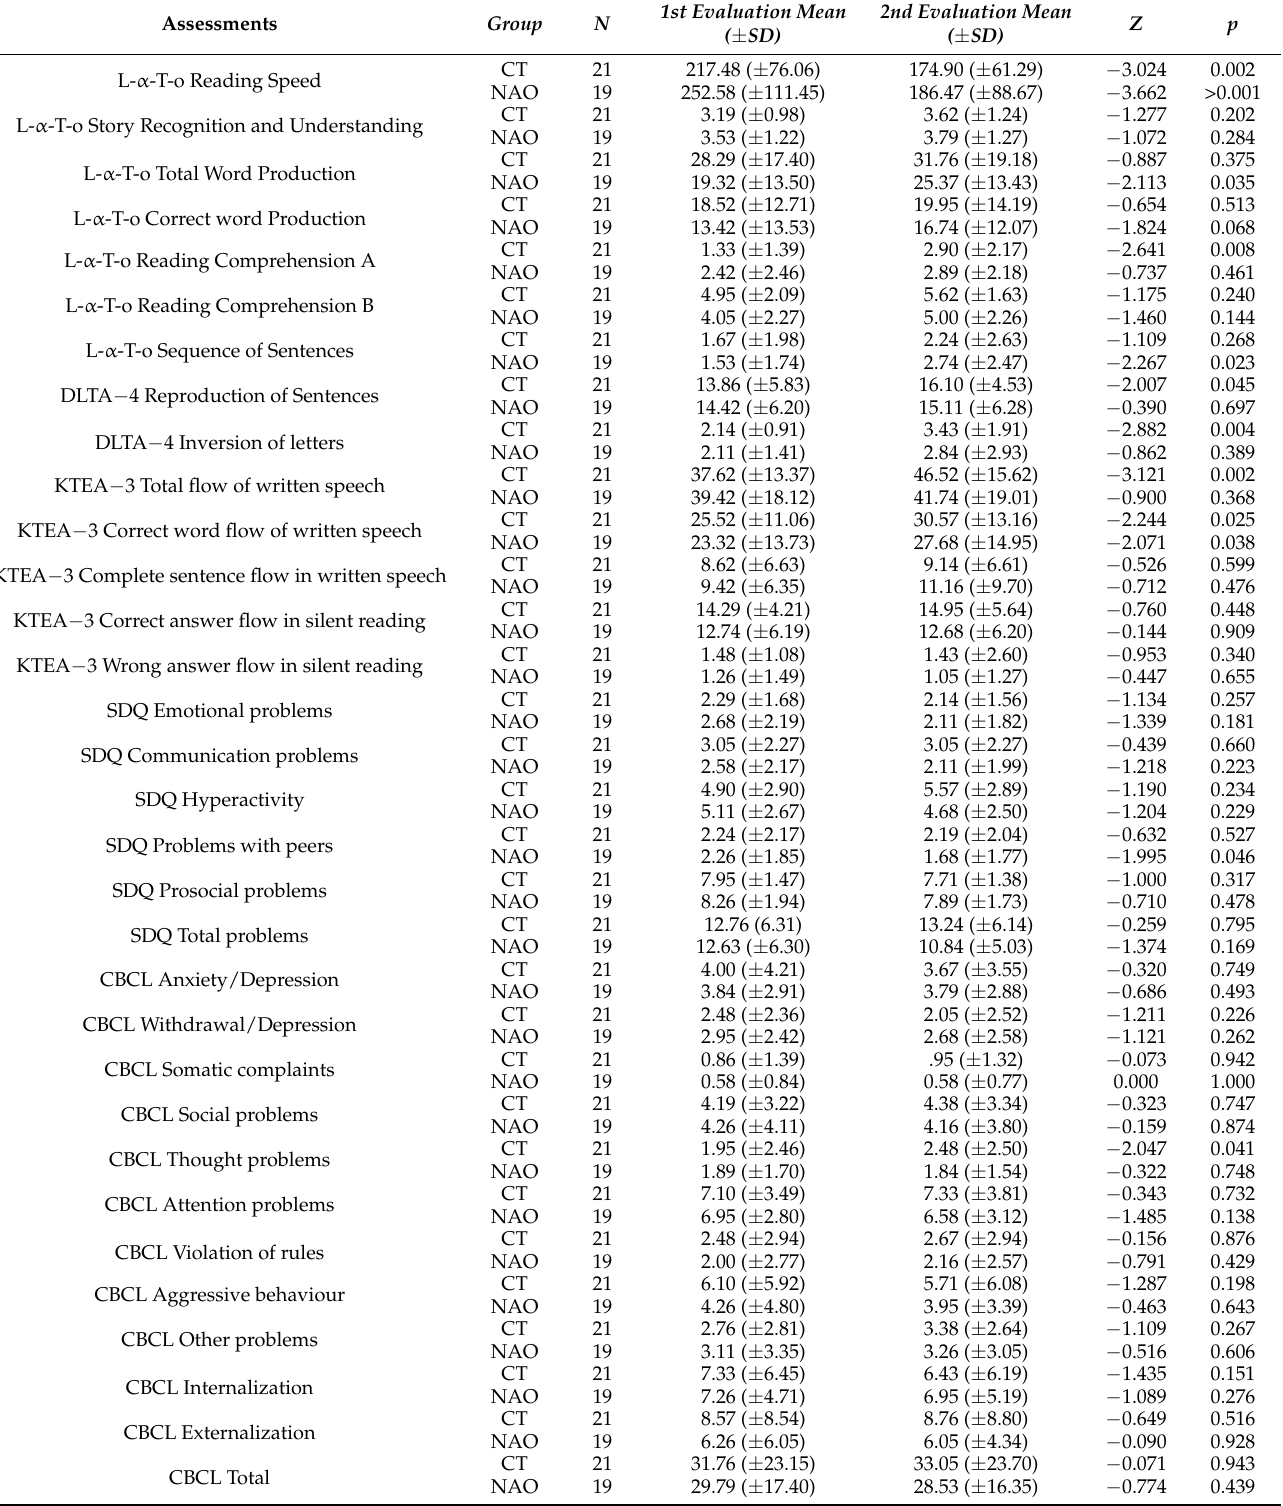
Table 1. Pre- (1st) and post- (2nd) intervention evaluation by